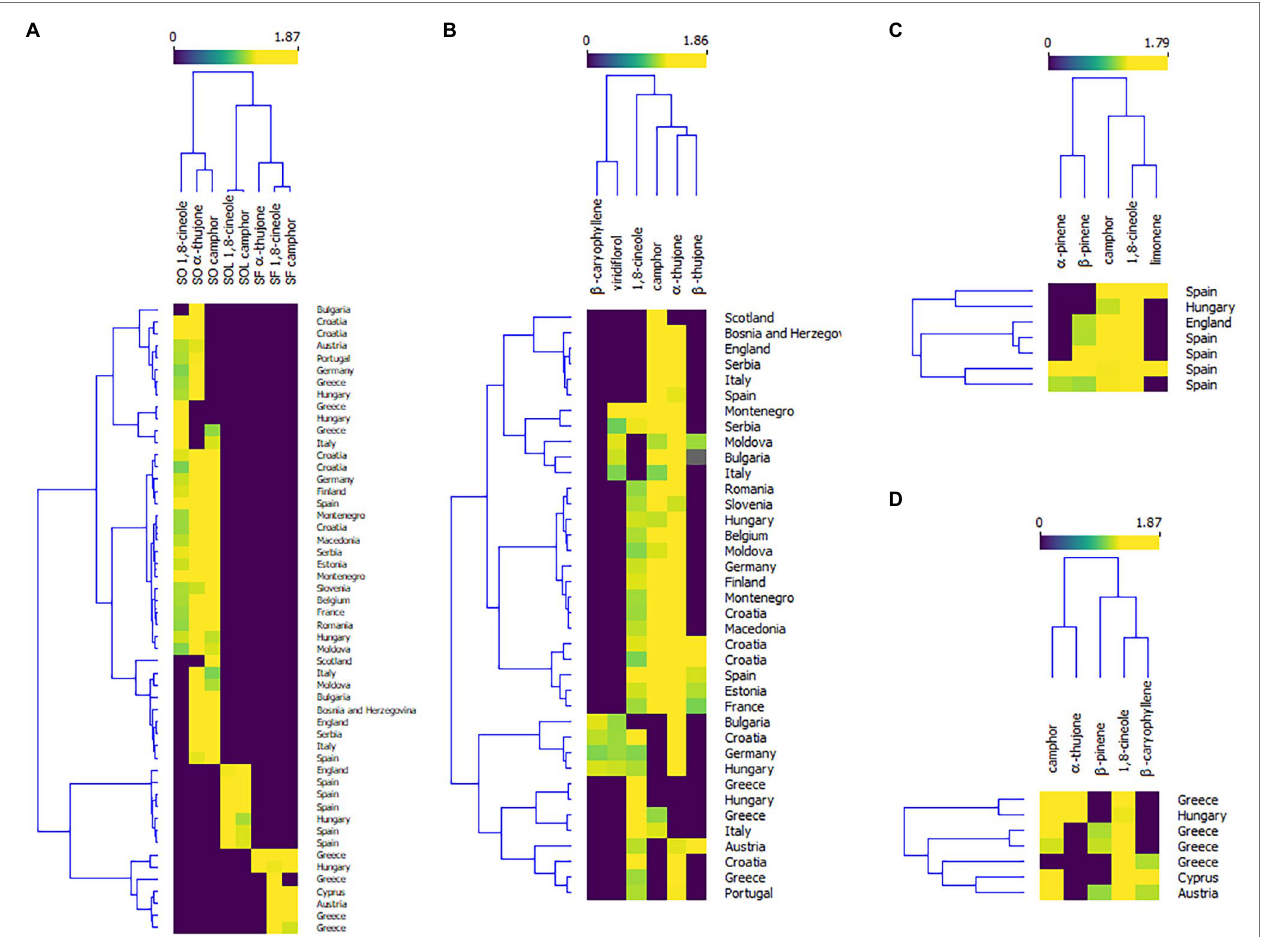
FIGURE 4 | Heatmaps of the levels of the essential oil constituents in of Salvia officinalis —SO, S. officinalis subsp. lavanulifolia —SOL, and S. fruticosa —SF. (A) Country of origin in relation to the percentage content of the major monoterpenes in all three species; (B) Country of origin in relation to the percentage content of the major monoterpenes in S. officinalis ; (C) Country of origin in relation to the percentage content of the major monoterpenes in, S. officinalis subsp. lavanulifolia ; and (D) Country of origin in relation to the percentage content of the major monoterpenes in S. fruticosa